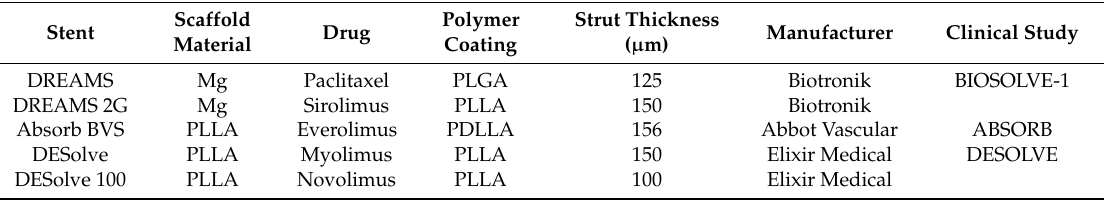
Table 2. Summary of fully bioresobable coronary stents with Conformite 1 Europe 1 enne.